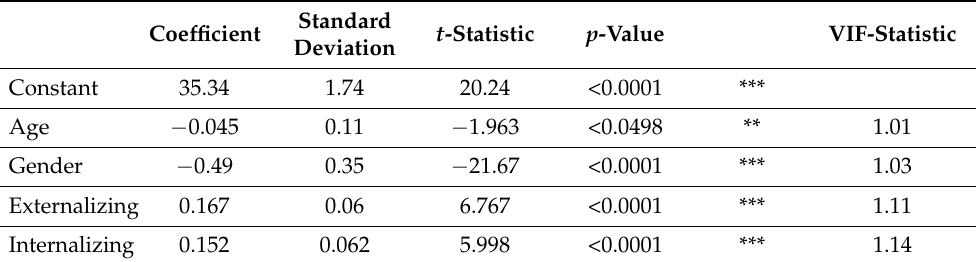
Table 3. Ordinary least squares: correlation, standard deviation, and t -statistic p -value.